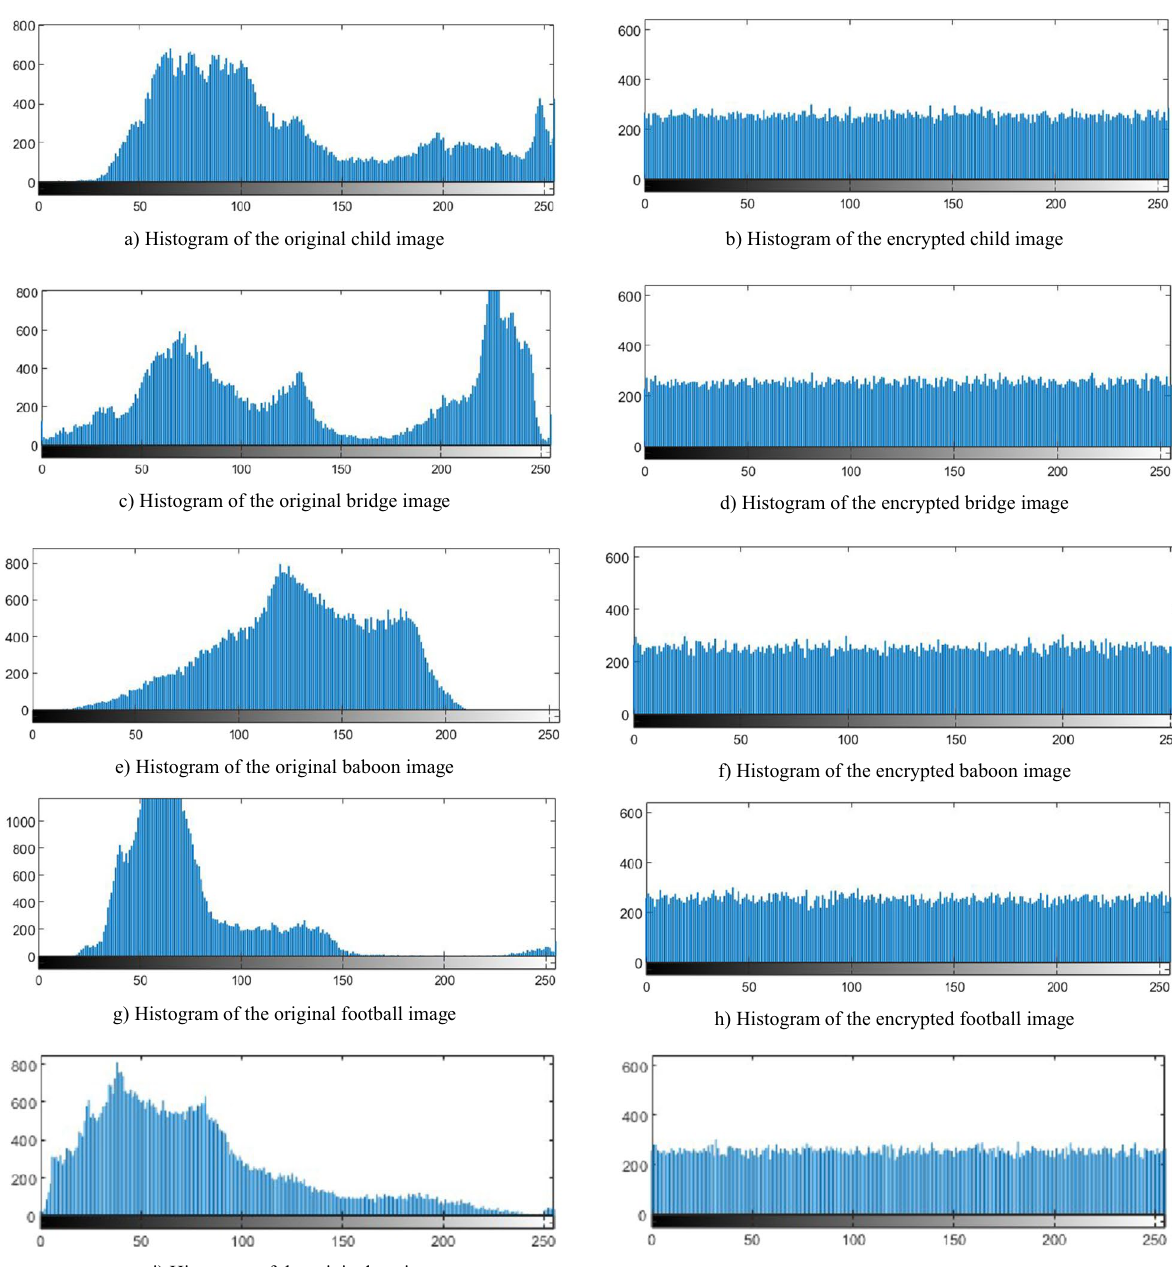
Fig. 13 Histograms of all original and encrypted images reported in Fig.